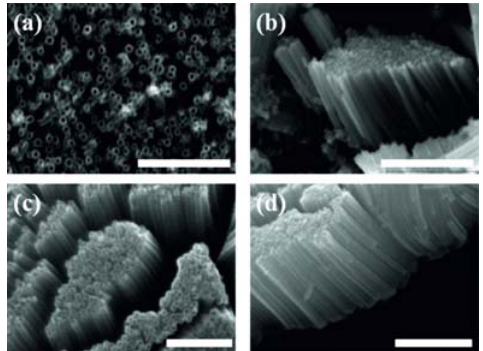
Figure 6. SEM images of TiO nanotube arrays obtained by anodizing Ti foil in glycerol 2 electrolyte at 40 V at ( a , b ) room temperature, scale bar = 2 µm for (a) and 5 µm for (b); ( c , d ) in an ice bath, scale bar = 500 nm for (c) and 1 µm for (d). Reprinted with permission from [54]. Copyright (2013) American Chemical